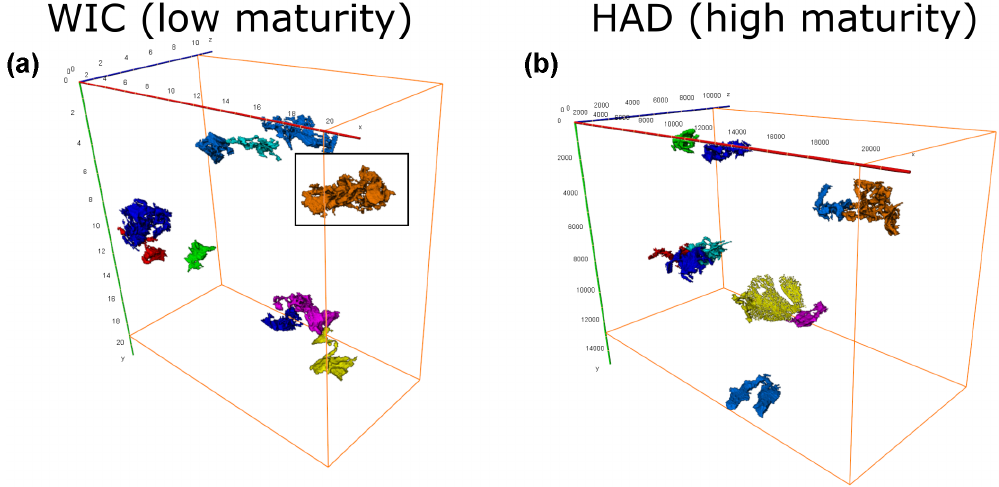
Figure 2. The 10 biggest pore clusters of sample WIC and HAD. No big differences were observed in size, pore size distribution and connectivity for the two samples. The yellow pore cluster in HAD was the only pore cluster which could be interpreted as a drying crack. All other pore clusters were interpreted as drying cracks.